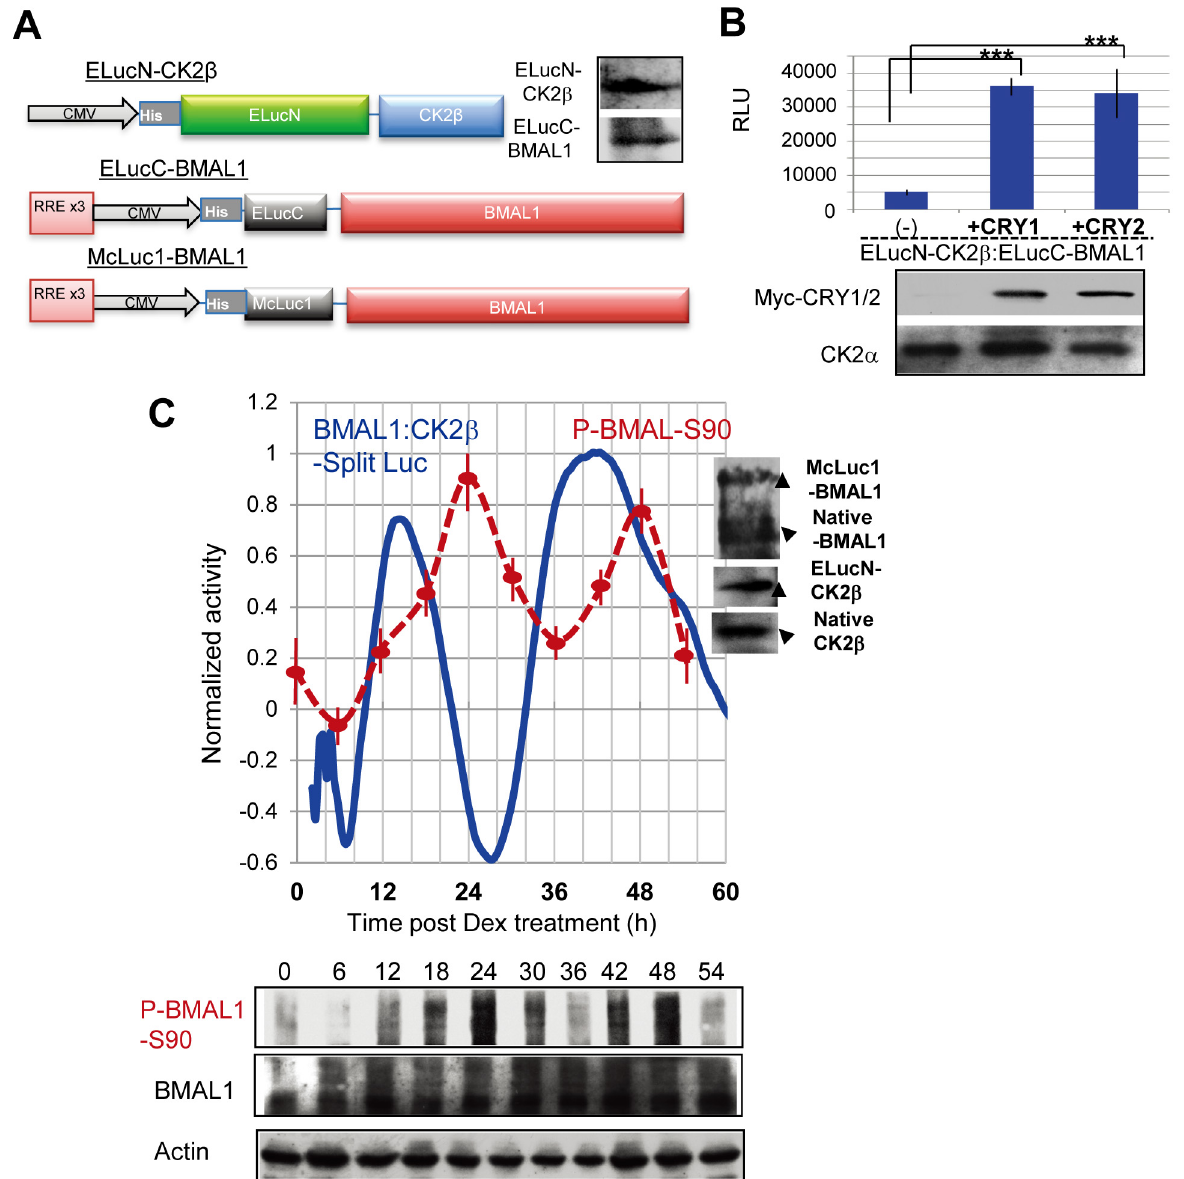
Fig 4. CRY-enhanced circadian oscillation of BMAL1 – CK2 β association in living cells. (A) Graphic representation of ELucN-CK2 β , McLuc1-BMAL1, and ELucC-BMAL1 vectors for real-time bioluminescence imaging of CK2 β -BMAL1 interactions as monitored by the Split Luc complementation system. IB analysis with anti-BMAL1 and CK2 β antibodies reveals ectopic expression of His-tagged ELucC-BMAL1 (~100 kDa) and ELucN-CK2 β ELucN-CK2 β (~70 kDa) in Cos7 cells. (B) Cos7 cells were transfected with ELucN-CK2 β and ELucC-BMAL1 (2.5 μ g), and either Myc-HA-CRY1, Myc-CRY2, or (control) pcDNA ( − ) (5 μ g). The presence of ectopically expressed CRY1/2 and native CK2 α was confirmed by IB analysis (lower panel). BMAL1 – CK2 β binding was monitored by real-time bioluminescence imaging and plotted as the average value of peak bioluminescence levels ( n = 5 experiments; upper panel). Error bars indicate SD. Note that BMAL1 – CK2 β binding was significantly facilitated by CRY1 and CRY/2. (C) Circadian rhythms in BMAL1 – CK2 β binding in Dex- synchronized U-2OS cells were monitored by real-time bioluminescence imaging of Split Luc activity (upper panel). The circadian profiles (Period = 25.3 h, Acrophase = 15.1 h) ( n = 5; blue line) are shown with normalized values to the maximum value that was set as 1. Expression of McLuc1-BMAL1, native BMAL1, ELucN-CK2 β , and native CK2 β was confirmed by IB analysis (upper panel, insets). The circadian profile of P-BMAL1-S90 levels (representative examples of n = 3 experiments) was determined by IB analysis (lower panel) with anti-P-BMAL1-S90), quantified and normalized to actin content. Maximum values were set as 1 (upper panel: dotted red line). Error bars indicate SD.